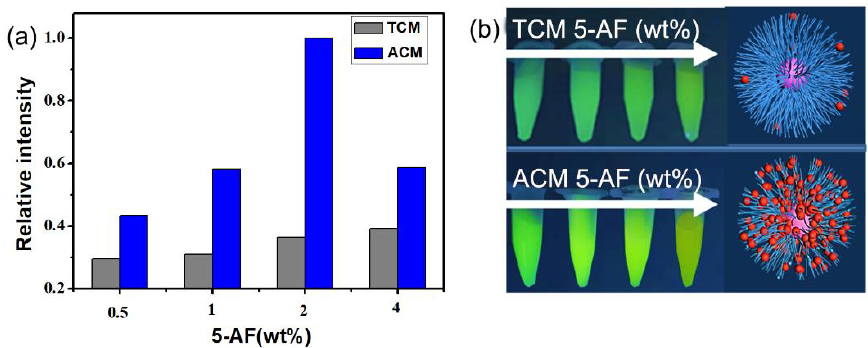
Figure 2. ( a ) The fluorescence intensity of HFNs by different coupling methods in aqueous solution; ( b ) digital photographs of HFNs in 1 mL centrifuge tubes under 365 nm UV lamp radiation.